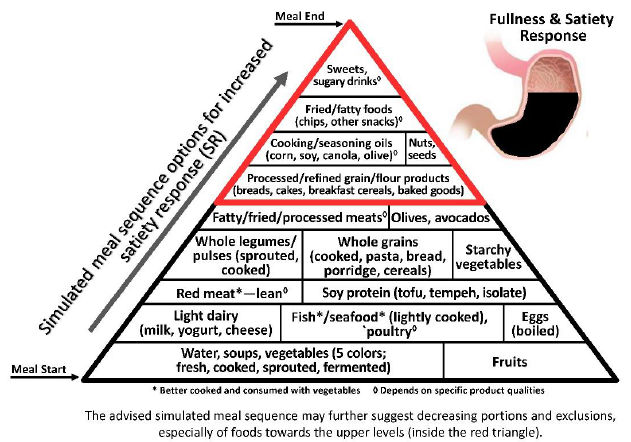
Figure 1. Figure 1. The Meal Sequence Pyramid per Satiety Response (SR) Axis. Foods are ranked according to fullness-related satiety per contribution to gastric filling (fullness proportional to stomach cavity), protein, fibre and hedonic aspects. Foods at the bottom of the pyramid that contribute to the greatest SR, being highest in innate / added / incorporated water and fibre and therefore w / v per kcal, are recommended to start the meal and prevent overconsumption; the next levels include foods high in innate / added / incorporated water and protein, which a ff ect both biochemically induced satiety-related hormones as well as w / v and therefore scored medium SR; and foods at the highest levels are the most energy-dense, highly processed and palatable foods, which contribute the least to fullness sensation per kcal and therefore would best be limited and scheduled toward the end of a satiating meal, when hunger is least likely to add to the motivation for further